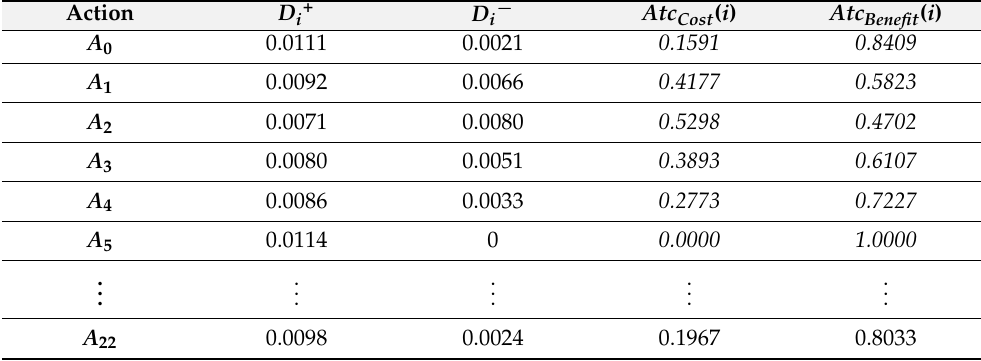
Table 12. The cost and benefits of the attacker’s